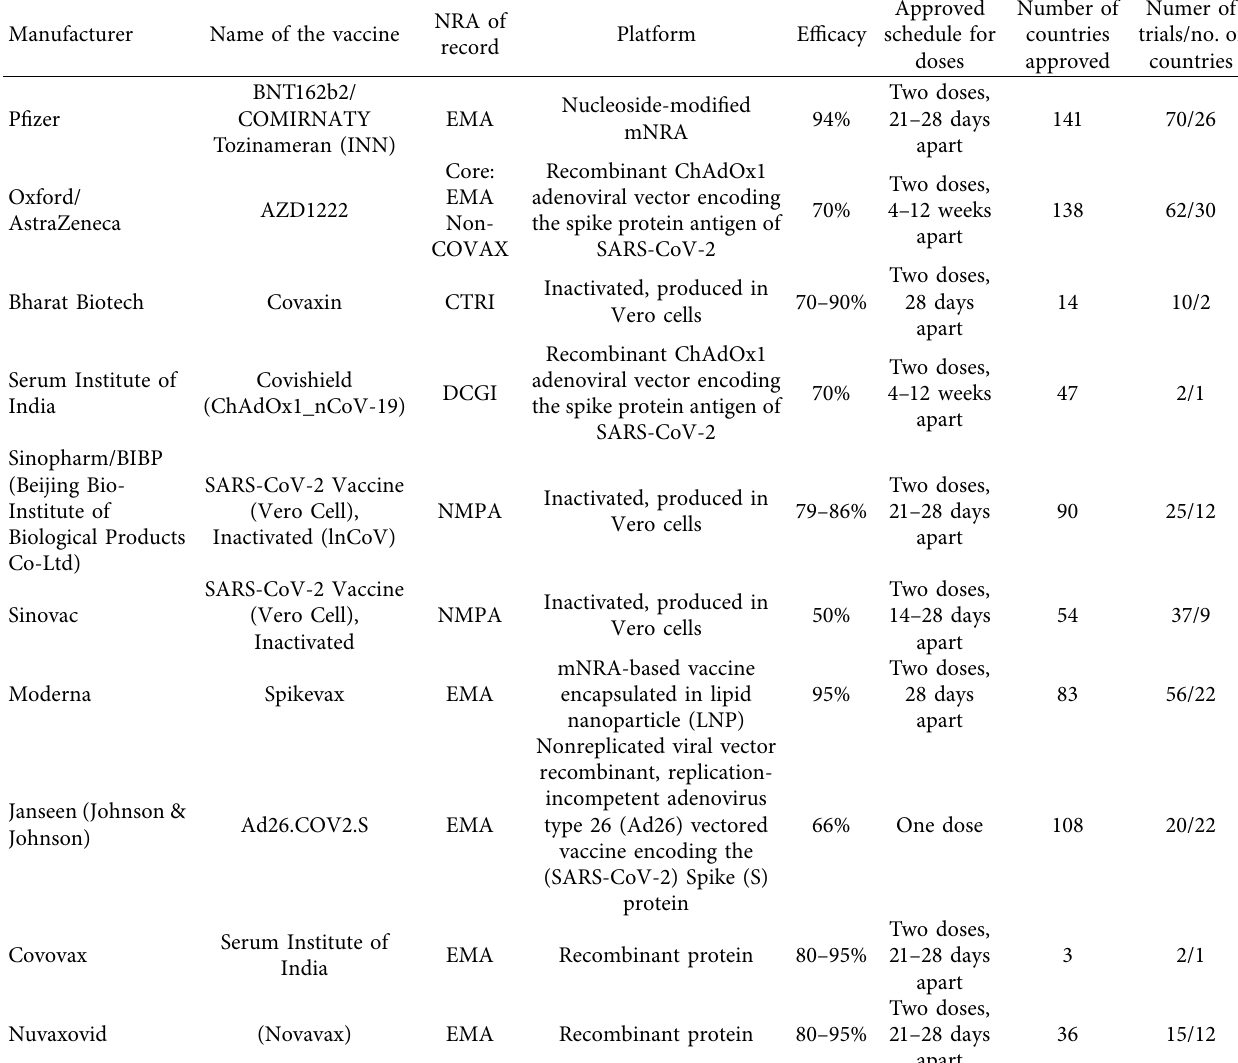
Table 1: The WHO EUL/PQ-approved vaccine for vaccination and its